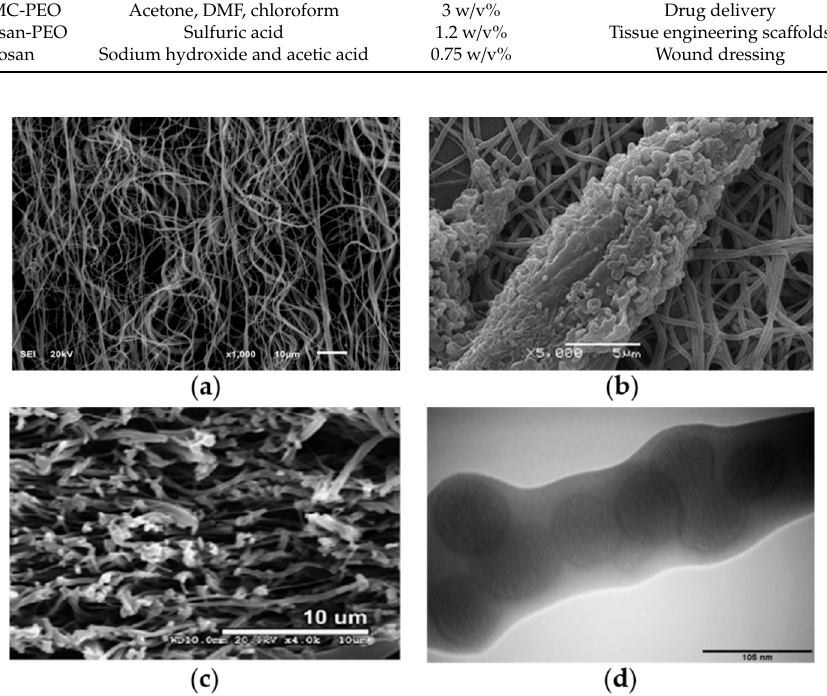
Figure 1. SEM images of different composite nanofibers for various biomedical applications: ( a ) chitosan–polyethylene oxide (PEO) composite nanofibers [43] (Copyright 2019, MDPI); ( b ) L929 cell seeded on carboxyethyl chitosan/polyvinyl alcohol (PVA) nanofibrous membrane after 48-h culture [44] (Copyright 2011, Elsevier); ( c ) cross-section of PCL/collagen nanofiber scaffolds [45] (Copyright 2009, Elsevier); ( d ) TEM image of highly aligned poly lactic- co -glycolic acid (PLGA)–gelatin nanofibers with 10 wt.% mesoporous silica nanoparticles [33] (Copyright 2015, Elsevier).